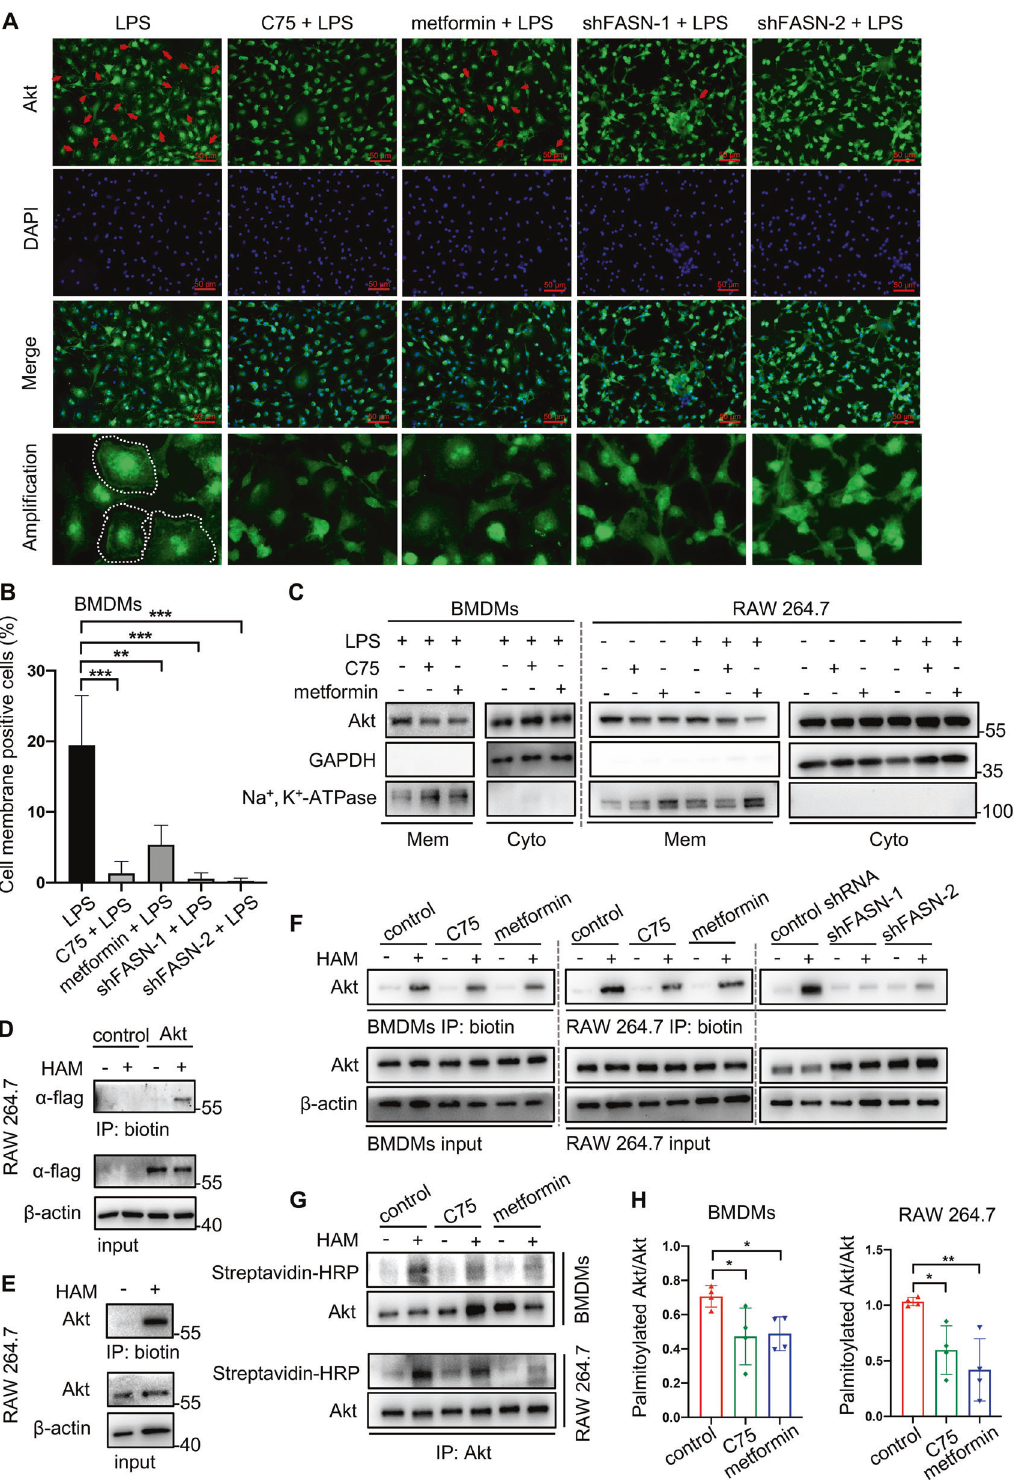
Fig. 5 Metformin and FASN regulated the membrane attachment of Akt and its palmitoylation. Macrophages in the presence of LPS were treated with metformin, C75 or Fasn shRNA lentivirus. A – C The membrane localization of Akt in response to a 15-min LPS treatment was determined by immuno fl uorescence ( A – B ) and Western blotting ( C ). D , E Akt possessed a posttranslational modi fi cation called palmitoylation, as determined in RAW 264.7 by acly-biotin exchange (ABE) method. The palmitoylation of exogenously-overexpressed Akt ( D ) and endogenous Akt ( E ). F – H The effect of metformin and FASN inhibition on Akt palmitoylation was determined by ABE method ( F ) and then con fi rmed again by immunoprecipitation (IP)-ABE method ( G ). The ratio of palmitoylated Akt/Akt was quanti fi ed ( H ). Data were represented as means ± SD. * p < 0.05, ** p < 0.01, *** p < 0.001, **** p < 0.0001,